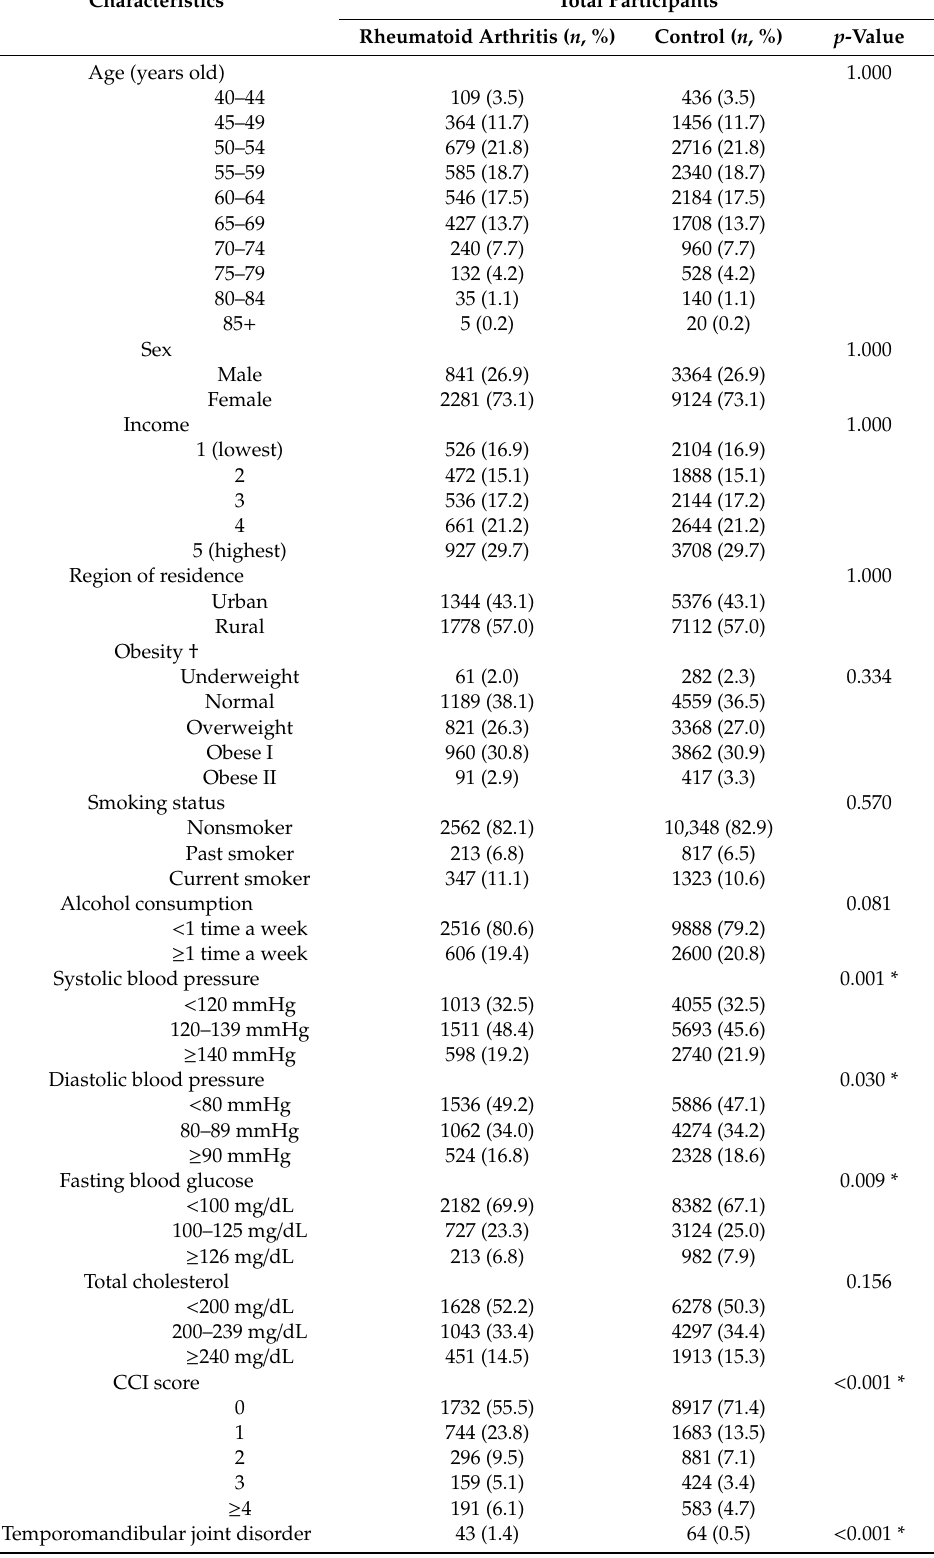
Table 1. General characteristics of the